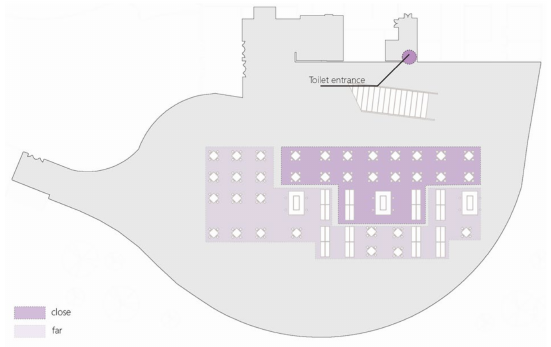
Figure 8. Schematic diagram of bathroom accessibility zoning.